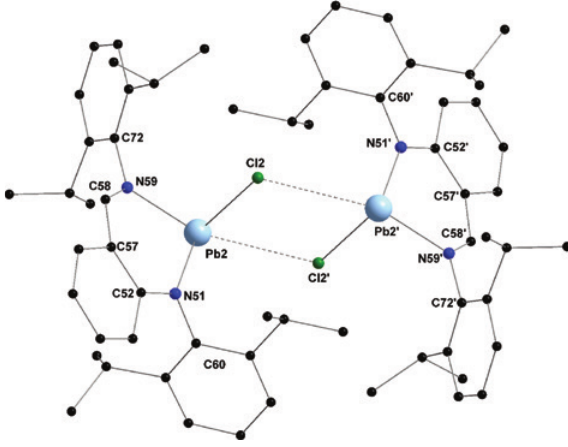
Figure 3: Representation of the molecular solid-state structure of one of the two independent components ( 1b ) in [{N^N iPr }PbCl] ( 1 ), showing the short Pb2 · · · Cl2 ′ and Pb2 ′ · · · Cl2 distances with the symmetry-related 1b ′ .